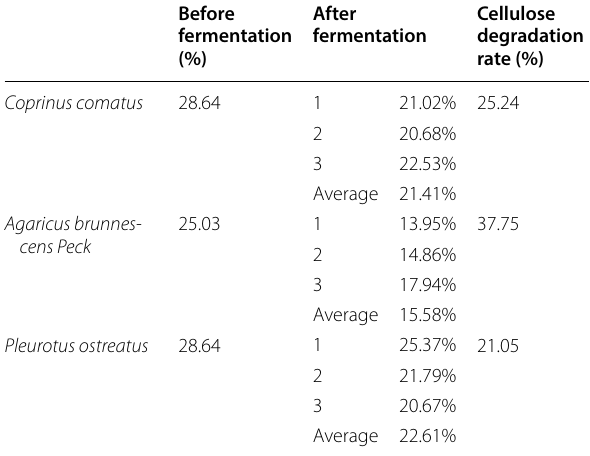
Table 1 Cellulose degradation rate of three kinds of edible